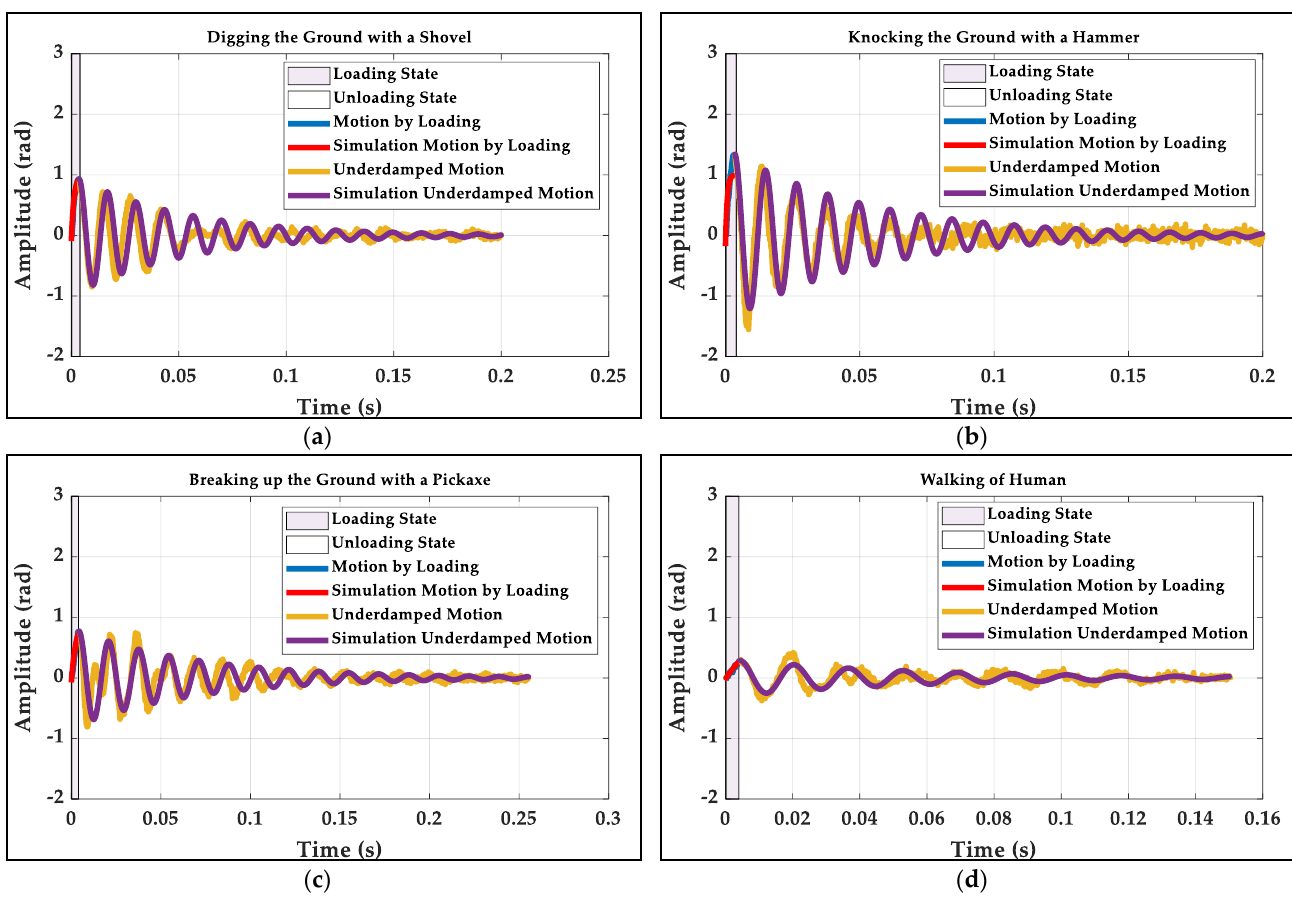
Figure A1. The actual and simulated vibrations of the four kinds of signals: ( a ) digging the ground with a shovel; ( b ) knocking the ground with a hammer; ( c ) breaking up the ground with a pickaxe; ( d ) walking of human.